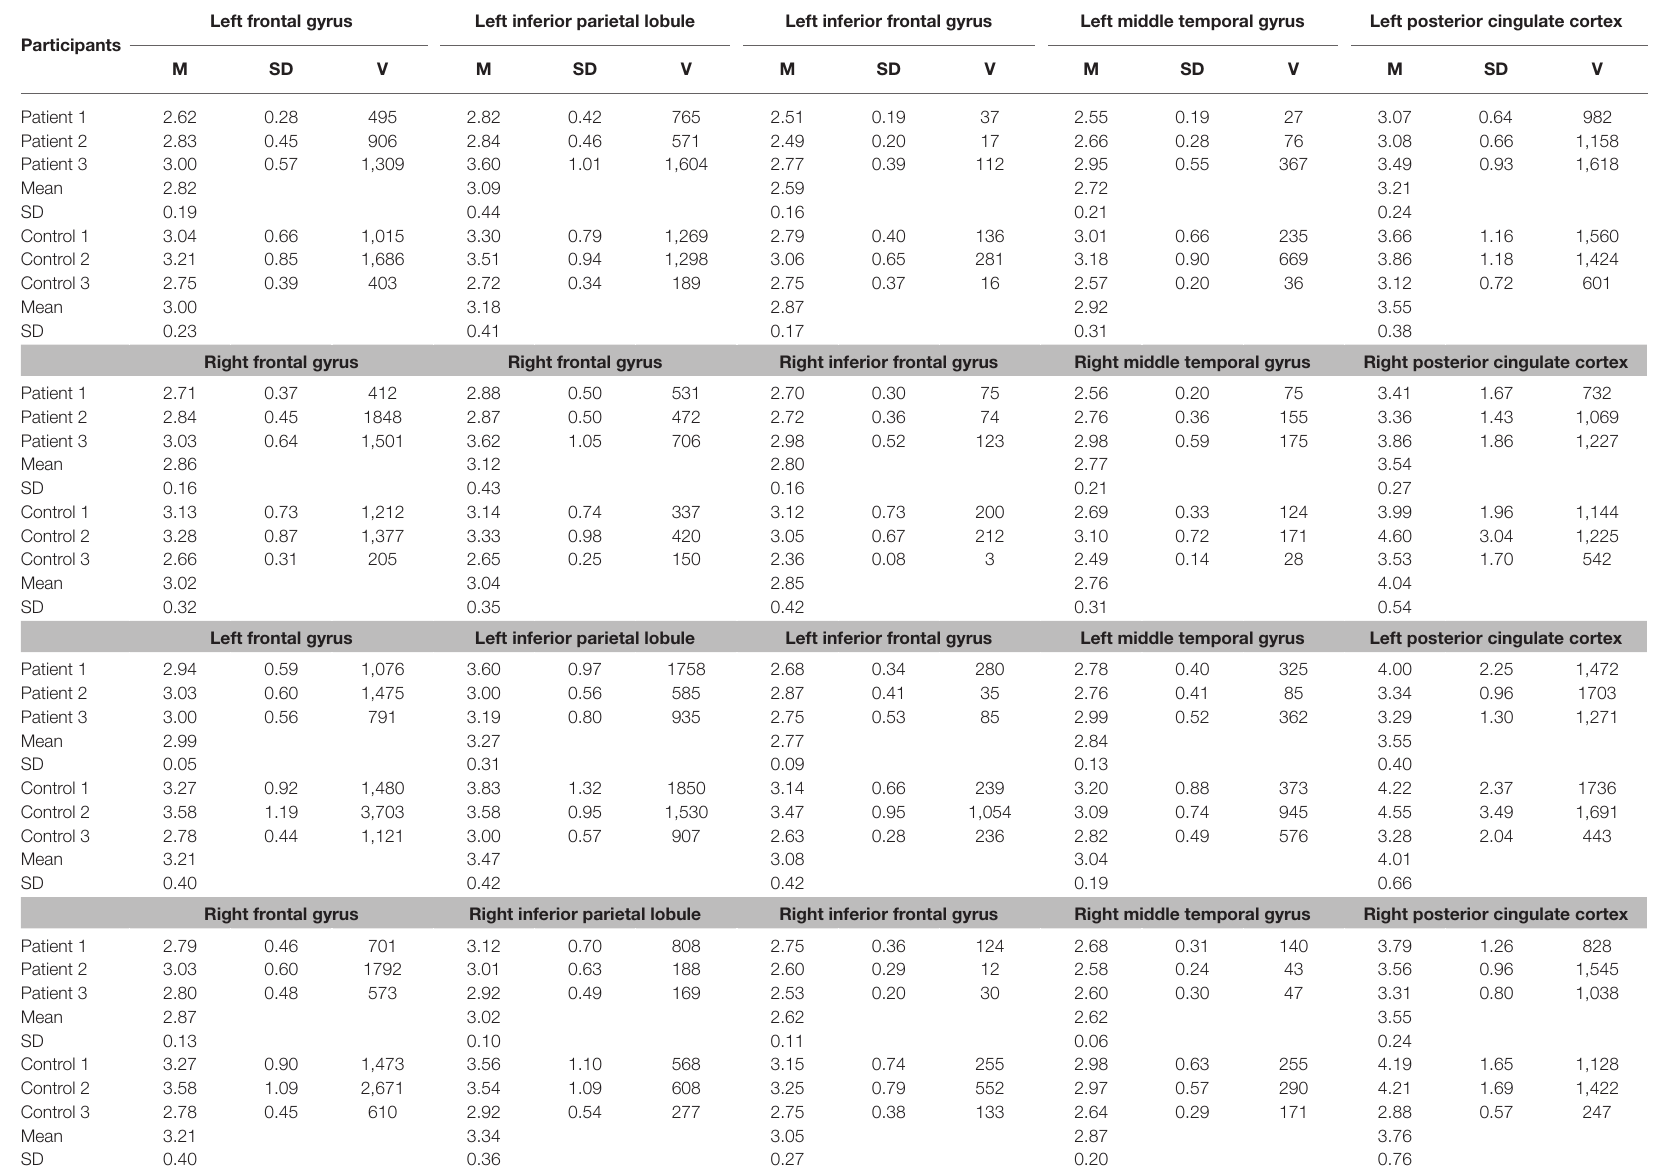
TABLE 3 | Mean, Standard Deviation and Voxels on the default mode network regions. Left frontal gyrus Left inferior parietal lobule Left inferior frontal gyrus Left middle temporal gyrus Left posterior cingulate Participants